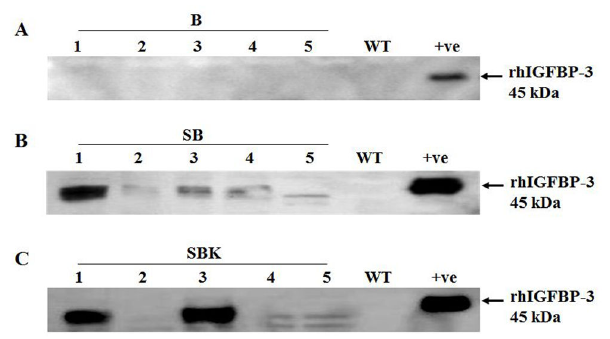
Figure 3. Western blot analysis of transgenic rice grains. Total protein was extracted from mature rice grains of different transformants. Recombinant hIGFBP-3 protein was used as positive control. (A) Lanes 1-5: five independent pSB130/Gt1/hIGFBP-3 transformants (B1-5); lane 6: WT;